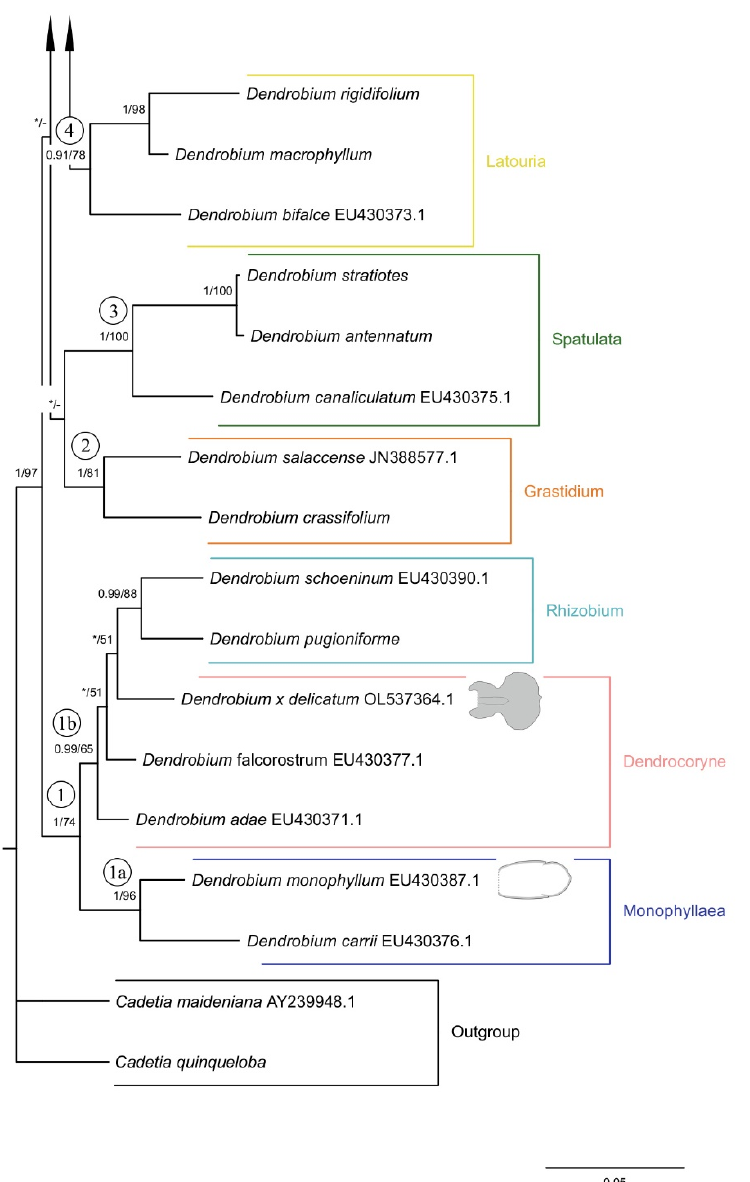
marked as an * and BS values of <50% were marked as -. Numbered black circles mark clades dis- cussed in the text.